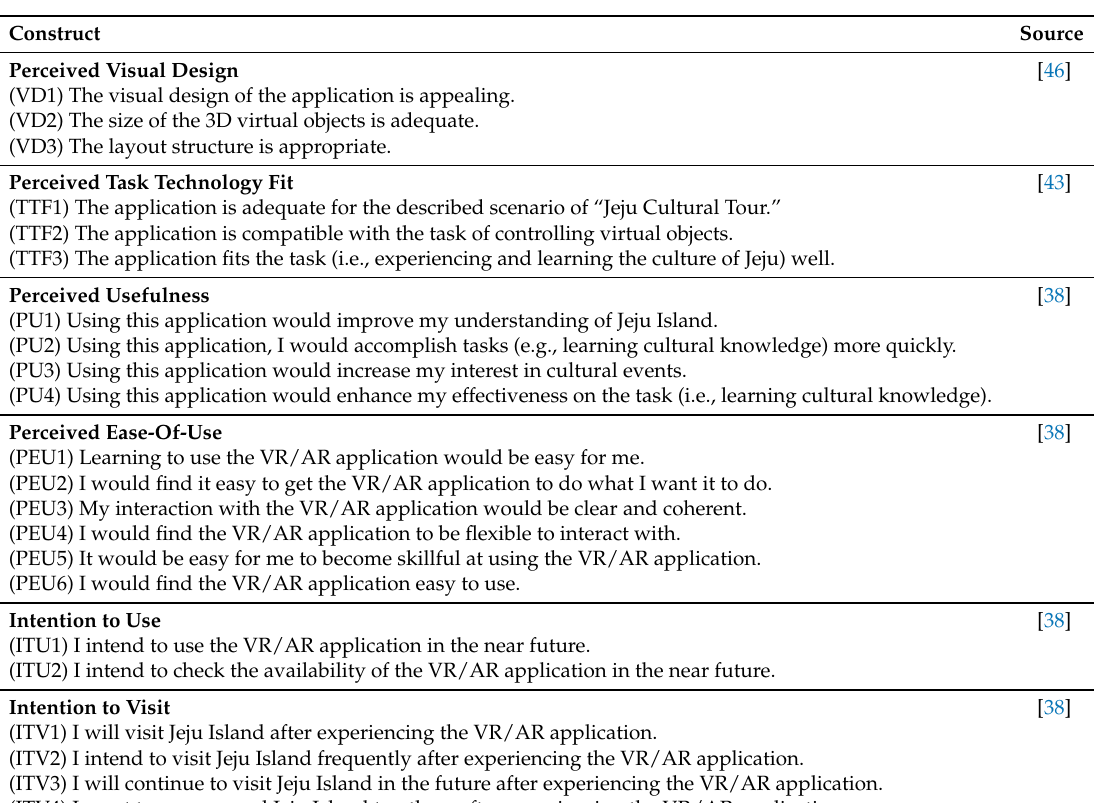
Figure 7. Conceptual research model [32]. Oval boxes indicate the constructs and the arrows show the hypotheses [1–8]. Table 1. Construct and